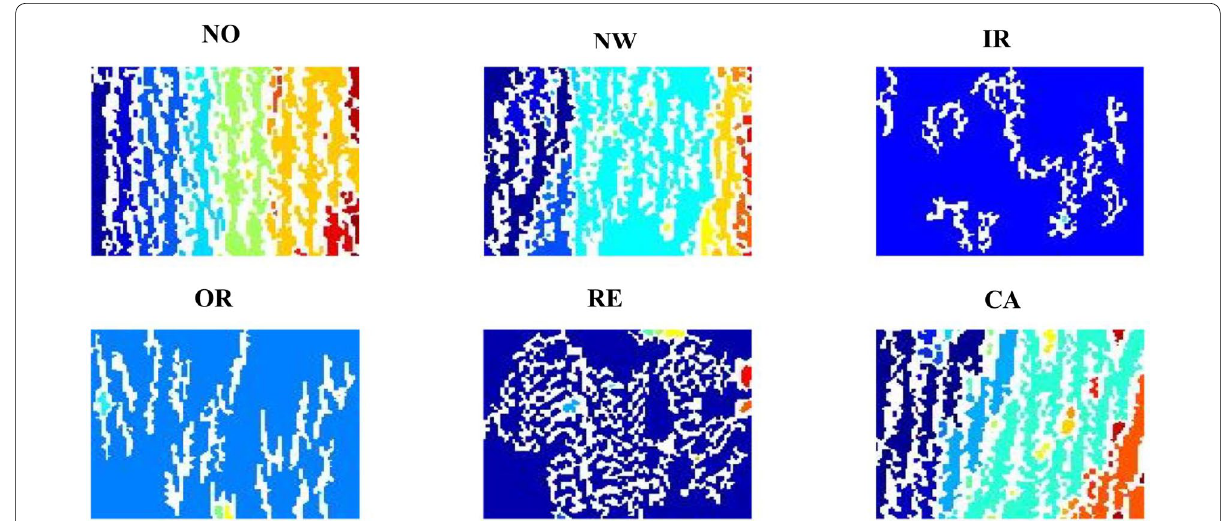
Figure 10 Typical examples of the RGBVI for the six health conditions of the first case study